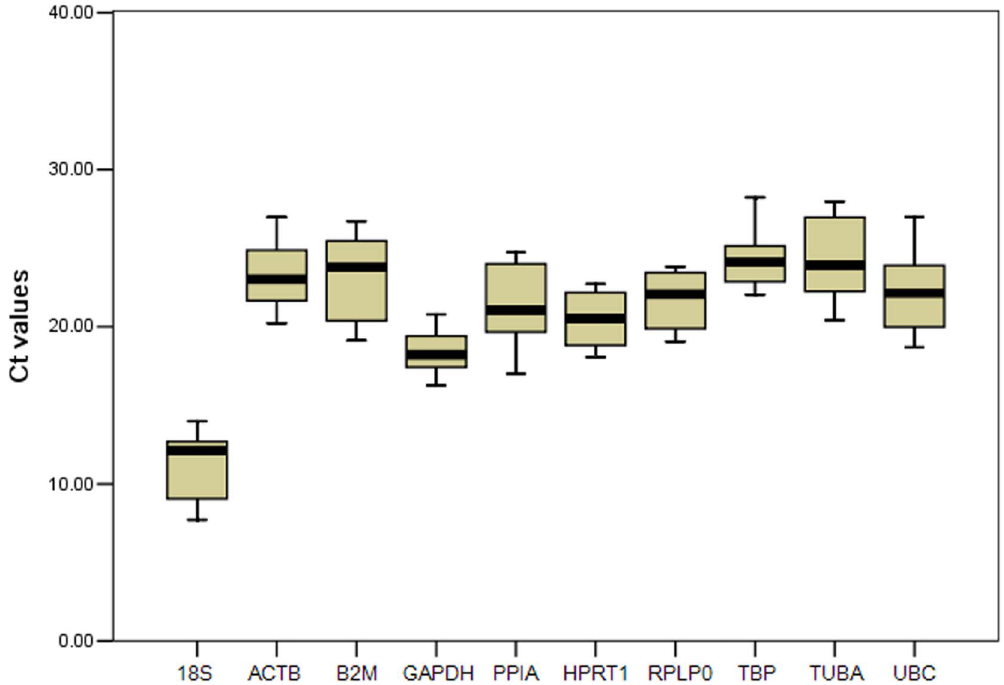
Figure 1. Range of Ct values for the candidate RGs obtained from all cDNA samples. Each box corresponds to 18S, ACTB, B2M, GAPDH, PPIA, HPRT1, RPLP0, TBP, TUBA and UBC and indicates the 25% and 75% percentiles. Whiskers represent the maximum and minimum values. The median is depicted as a line across the box.